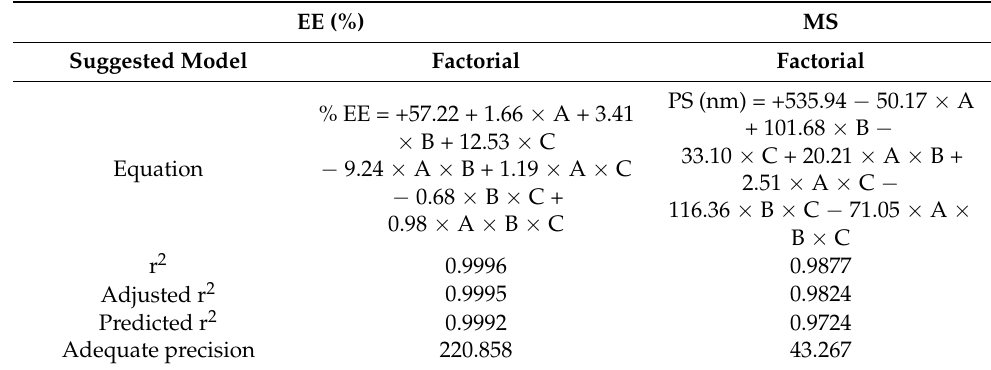
Table 2. Results of ANOVA analysis of entrapement efficiency and mean size of the berberine loaded